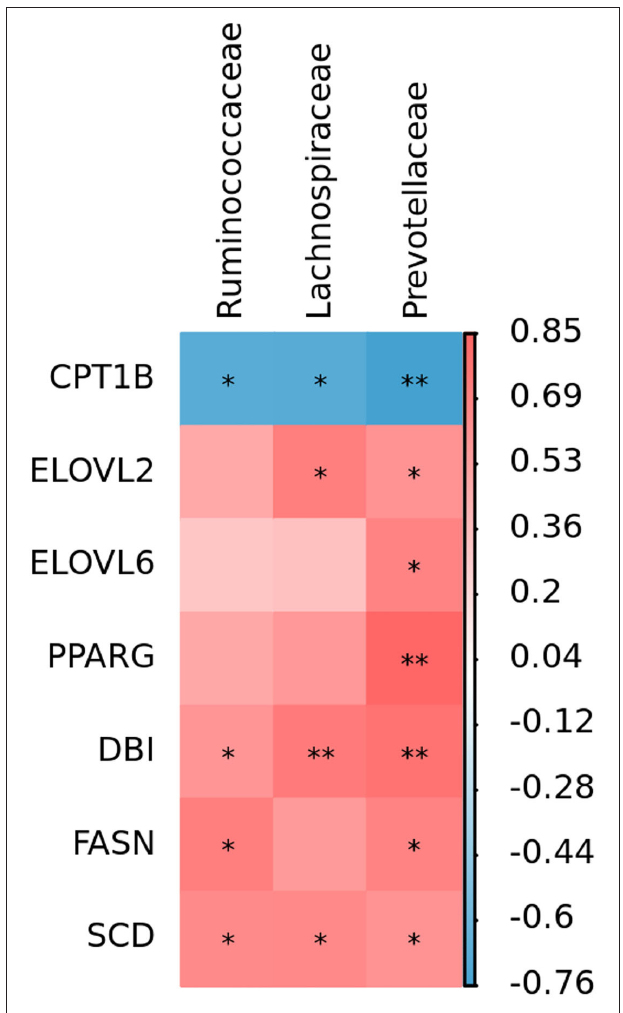
FIGURE 5 | Spearman’s analysis of PFF effect between gut microbiota and liver metabolism-related genes. * p < 0.05, ** p < 0.01.